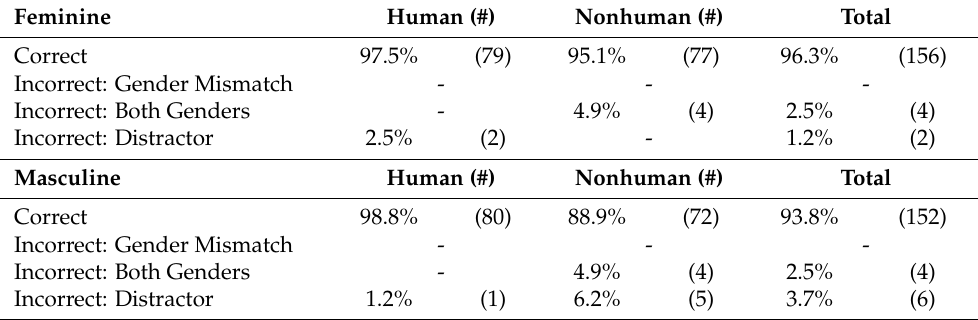
Table 3. Picture selection task results by gender and the [ ± Human] feature, L1 group. (# =